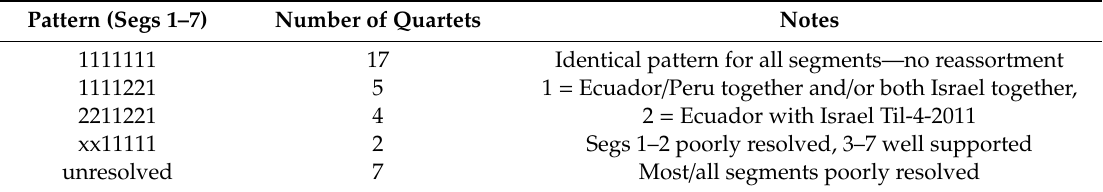
Table 2. Topological patterns of the first seven TiLV genomic segments, and distribution of the 35 possible quartets among the observed